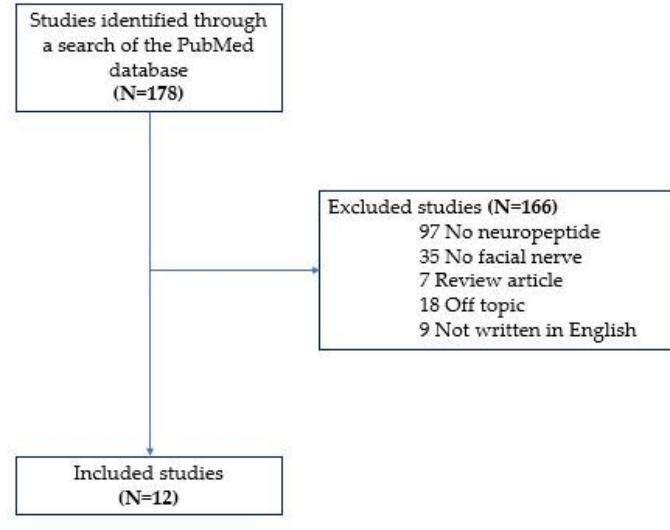
Figure 1. Review flow